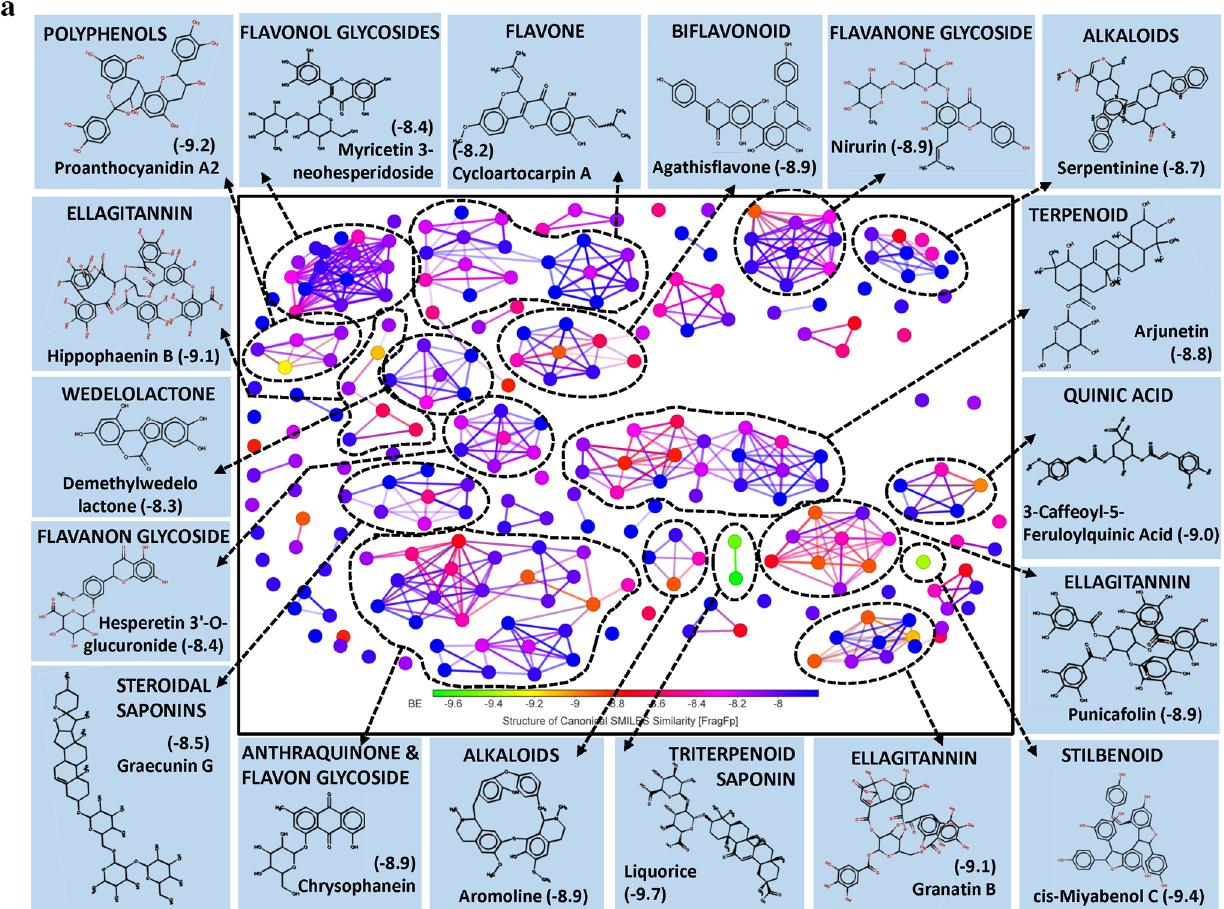
Figure 2. ( a ) Structural activity relationship: Correlation of canonical SMILES structure similarity (data points are joined by colored lines) and binding energy (represented in different color shades of data point) of selected plant secondary metabolites (PSM) evaluated against SARS-CoV-2 TMPRSS2 using Data Warrior software. Structurally similar molecules are grouped in dotted lines and a representative molecule with low binding energy (kcal/mol) (values in parenthesis) is represented in box. Among top ranked PSM studied, > 32% found belonging to Flavonoid glucoside and other major groups are ellagitannins and triterpenoids. ( b ) Data analysis of selected PSM against SARS-CoV-2 TMPRSS2. ( A ) Bioavailability radar chart representing lipophilicity (LIPO), Molecular weight (SIZE), Topological polar surface area (POLAR), Solubility (INSOLU), Flexibility (FLEX) and Saturation (INSATU) along with Bioavailability score (BAS) of selected molecules, ( B ) 3D visualization of protein–ligand interaction using PyMOL (selected amino acid residue of target site of protein are colored in cyan, and ( C ) 2D visualization of different types of interactions between ligand and target site of protein using Discovery Studio software (different types of interactions are represented in color